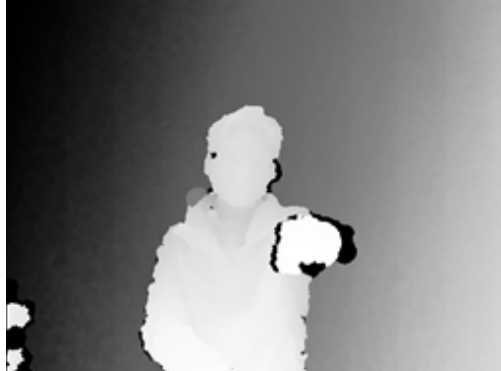
Figure 3. Arm extension motion to initialize the hand detection